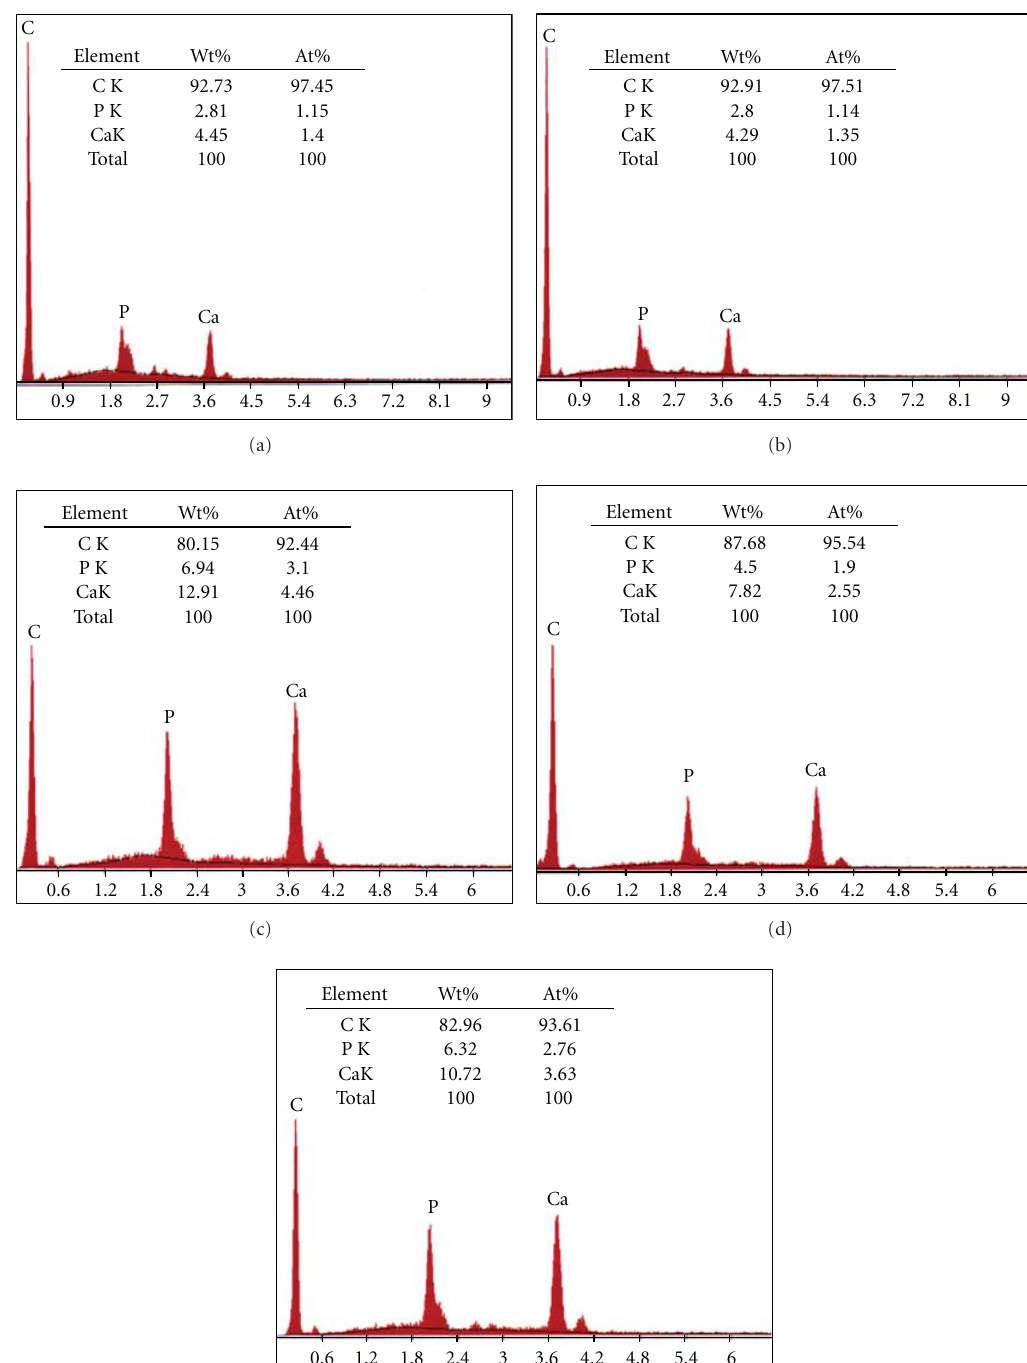
Figure 9: EDX analysis of UHMWPE/HDPE/PEG//HA composites for (a) 10, (b) 20 (c) 30, (d) 40, and (e) 50 phr HA content.